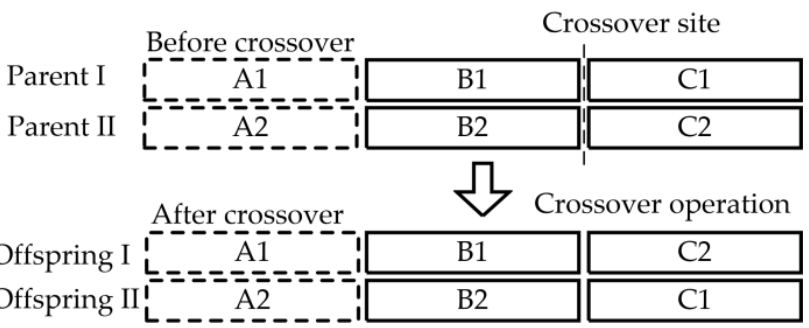
Figure 7. Crossover